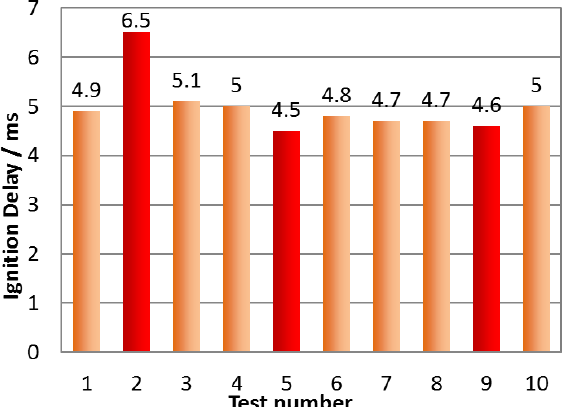
Fig. 3. Measured ignition delay of triglyme-HTP; the cases where the oxidizer droplets did not hit the pool in the centre are marked red As shown in Fig. 3, the measured ignition delay did not vary between the cases much. The average ignition delay was 4.98 ms and the standard deviation was 0.57 ms. How- ever, if the cases where the droplets did not hit the fuel